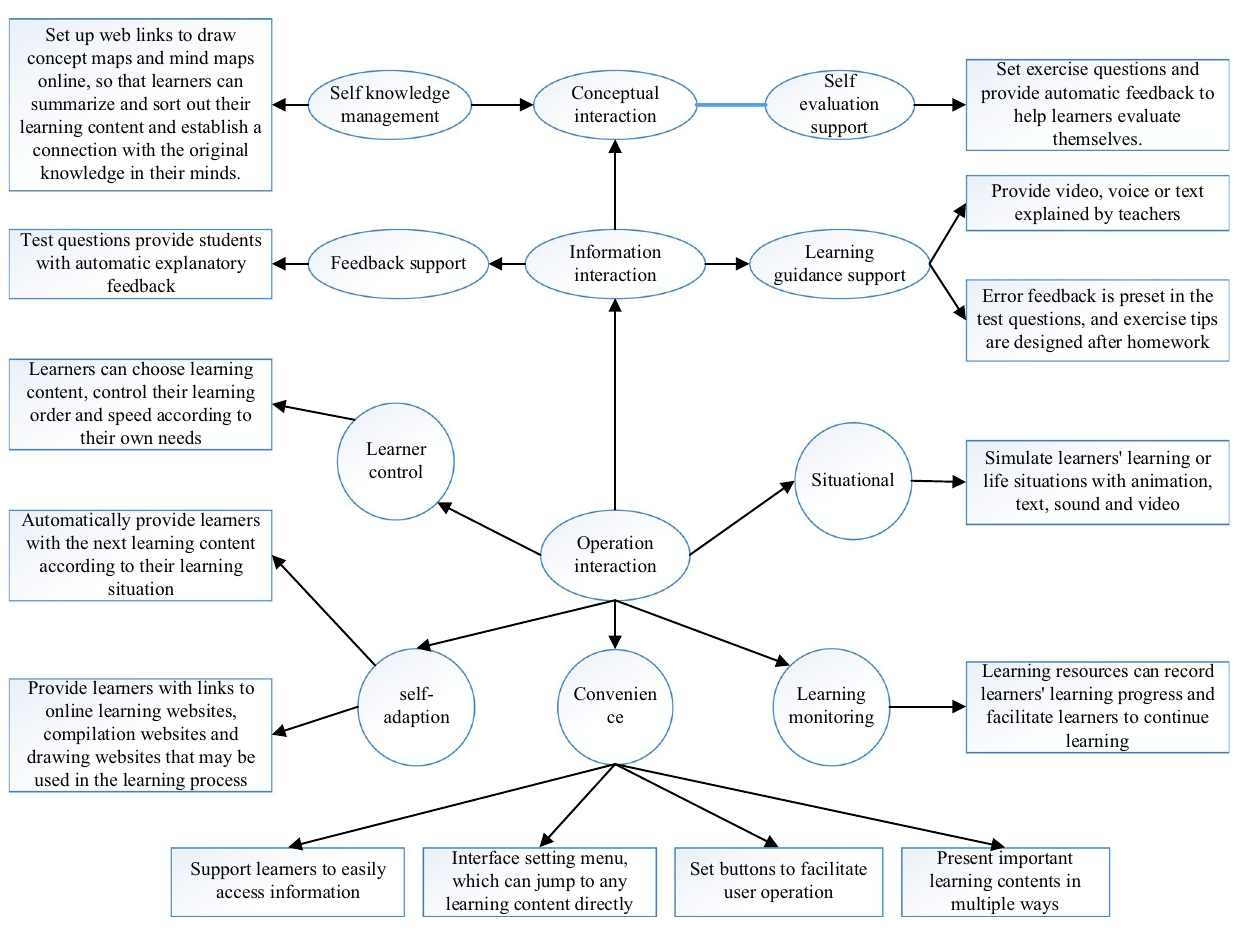
Fig. 6 Interactive learning resource design model Table 2 Comparison of baseline data of two groups of interns